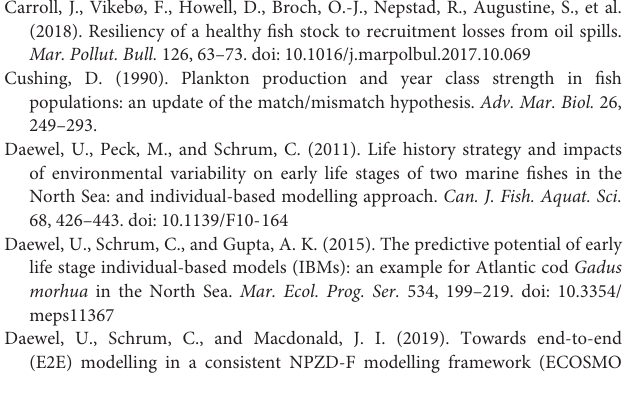
Supplementary Figure 1 | SGs (black stars) and every 100th drift trajectory of eggs/larvae from spawning until late July during 1995. Supplementary Figure 2 | SGs (black stars) and every 100th drift trajectory of eggs/larvae from spawning until late July during